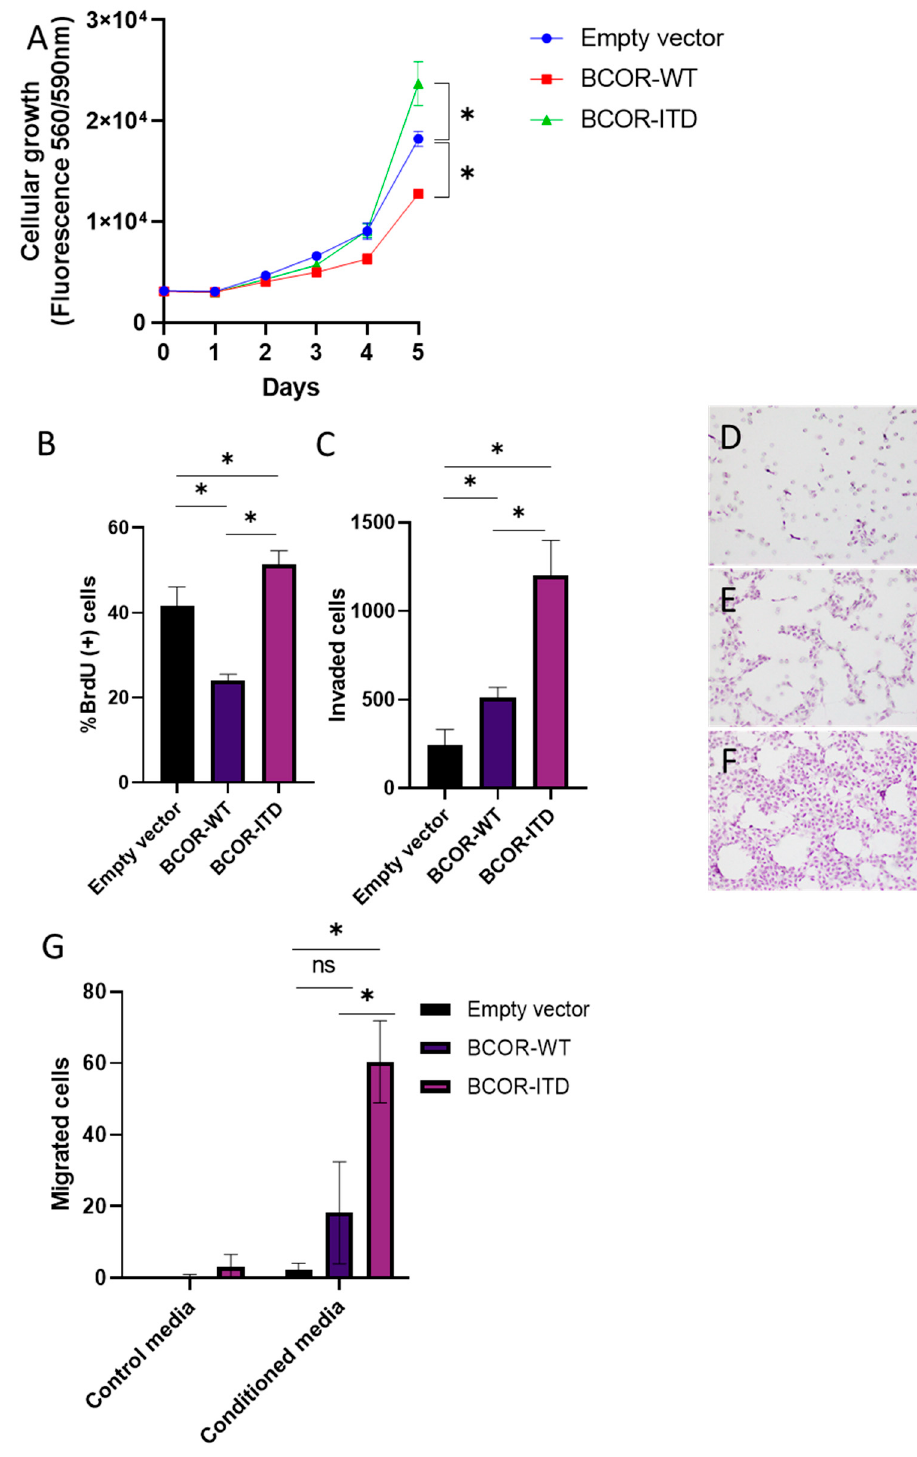
Figure 4. BCOR E7–15 -ITD overexpression increased cellular growth, invasion, and migration of murine neural stem cells. ( A ) Increased growth of BCOR E7–15 -ITD as compared to BCOR E7–15 -WT and control mNSC with empty vector measured by cell titer blue assay. ( B ) Increased proliferation of BCOR E7–15 -ITD as compared to BCOR E7–15 -WT measured by BrdU incorporation. ( C ) Increased invasion of BCOR E7–15 -ITD as compared to BCOR E7–15 -WT and control mNSC. ( D – F ) Representative images of transwell invasion assay. Empty vector ( D ), BCOR E7–15 -WT ( E ), and BCOR E7–15 -ITD ( F ). ( G ) Increased invasion of BCOR E7–15 -ITD as compared to BCOR E7–15 -WT and control mNSC. (* p < 0.05, analyzed by Tukey’s test. Data shown as mean ± SD).